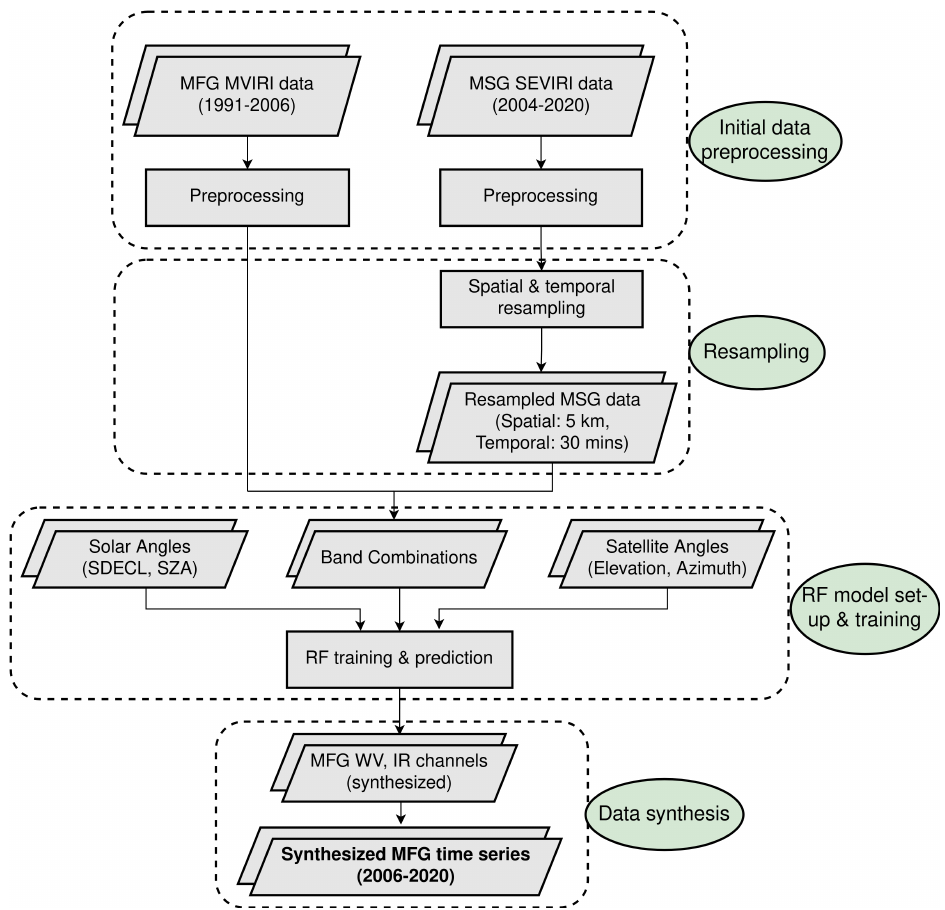
Figure 1. Flowchart depicting the methodology followed for the inter–calibration of MFG and MSG datasets. (SDECL: Sun Declination, SZA: Solar Zenith Angle, and RF: Random